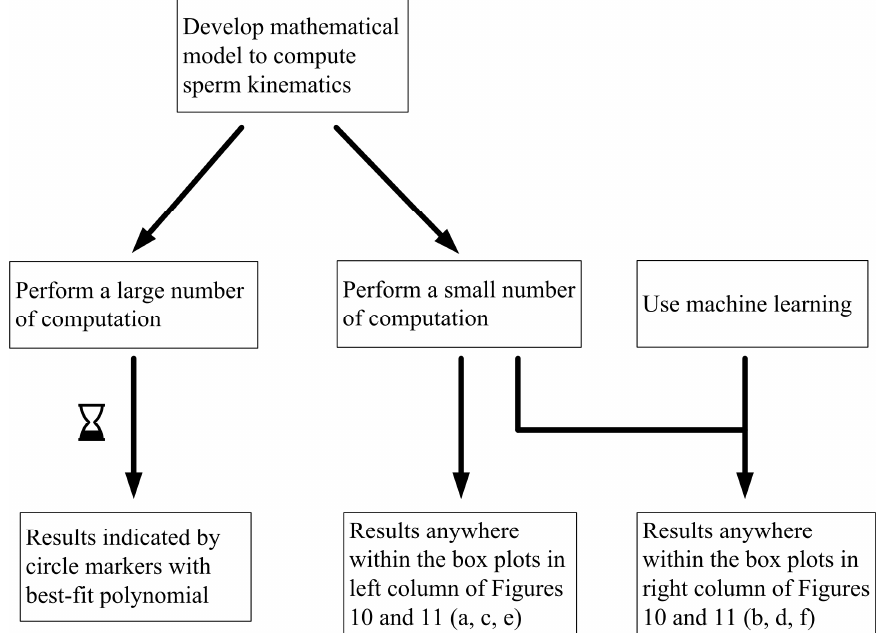
Figure 9. Flowchart illustrating possible approaches to investigate the non-deterministic process of sperm sorting.